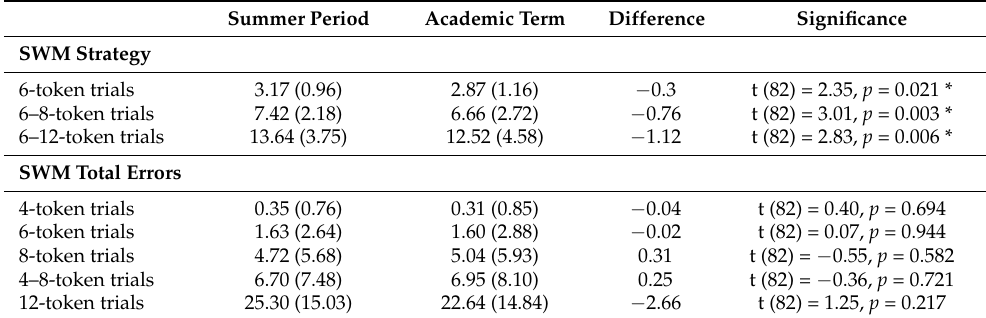
Table 2. Participant spatial working memory scores at each time point. * signifies p <